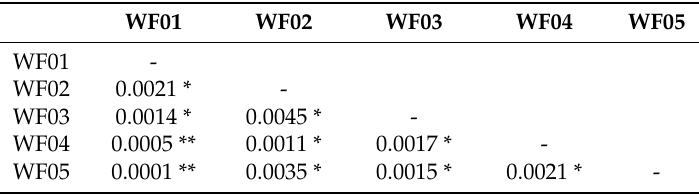
Table 4. Results of ANOVA between extracted WRSFs.